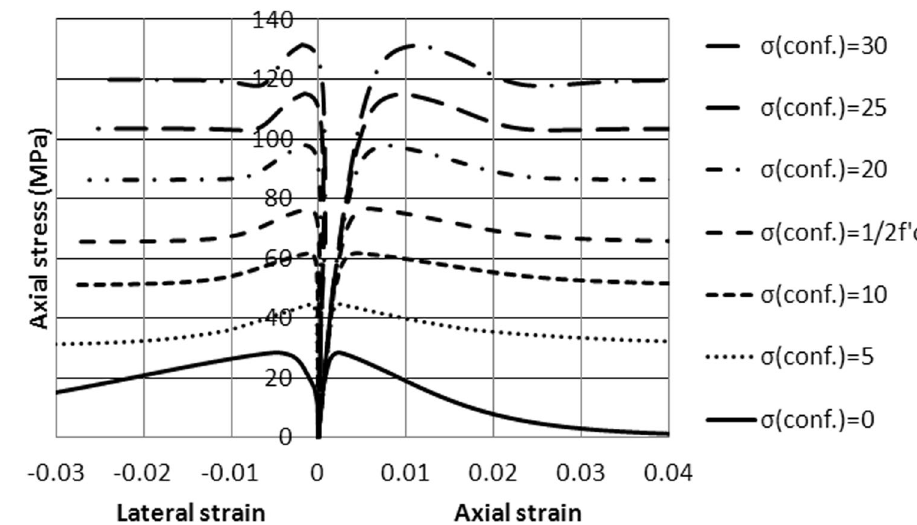
Fig. 11 Effect of confinement on compressive behavior of CSCM material model.